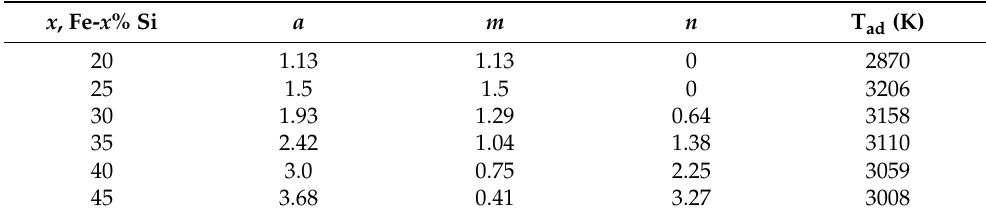
Table 1. Stoichiometric coefficients ( a , m , and n ) and adiabatic temperatures (T ad ) of Reactions (1) under different Si percentages ( x ) in terms of Fe- x %Si. x , Fe- x % Si a m n T ad (K)